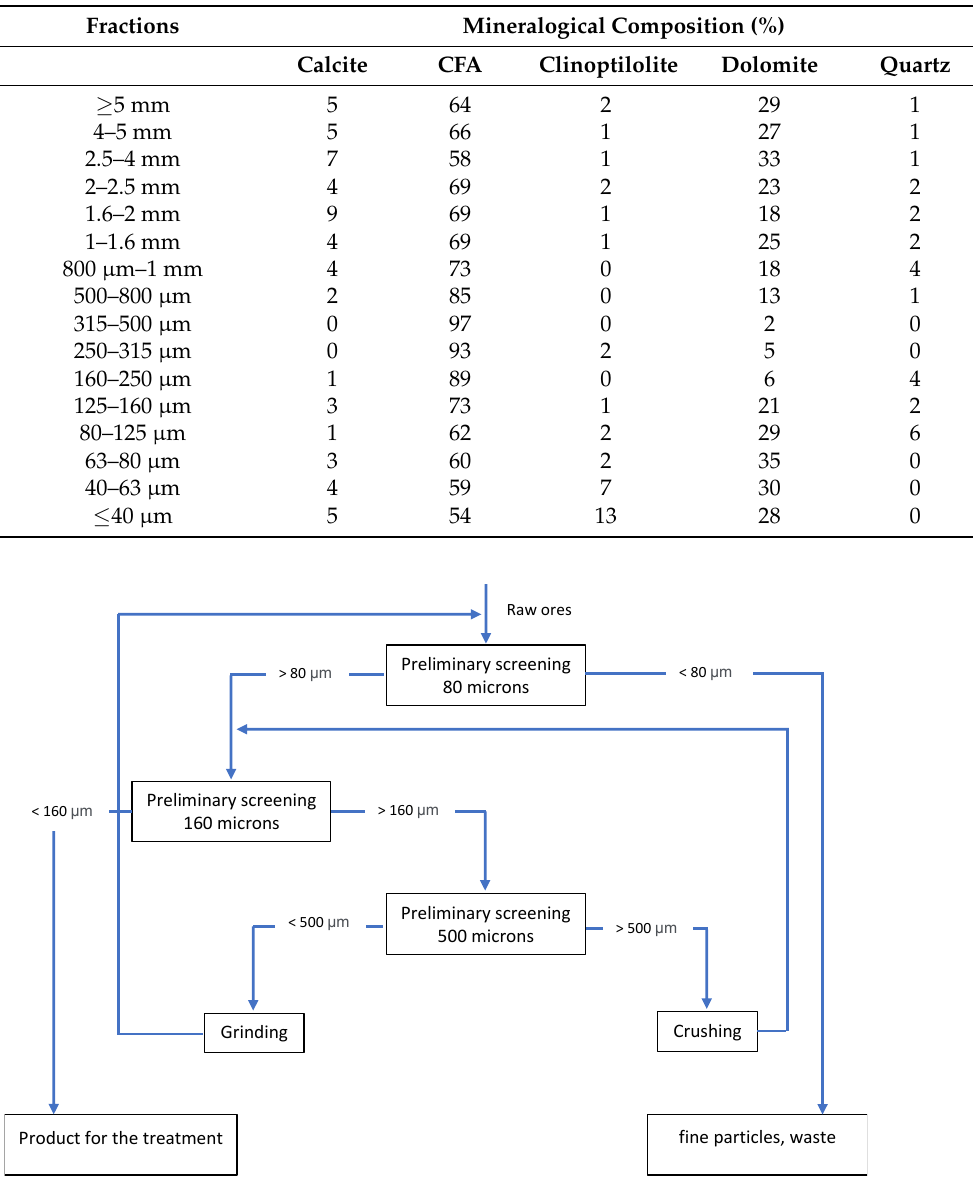
Table 4. Mineralogical composition of different fractions of phosphate ore from Djebel Onk.